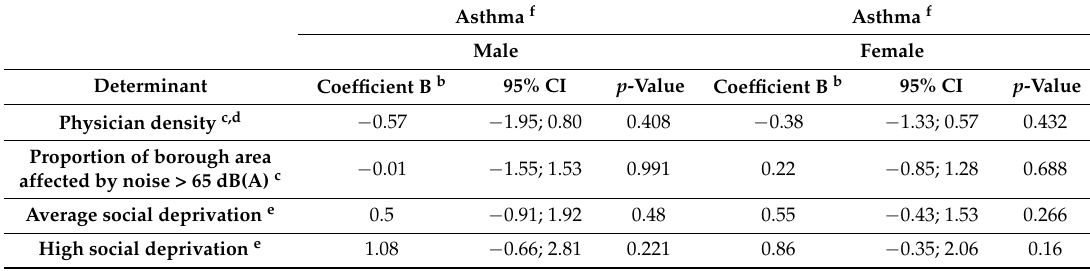
Table 7. Associations of determinants on asthma, Hamburg, Germany a